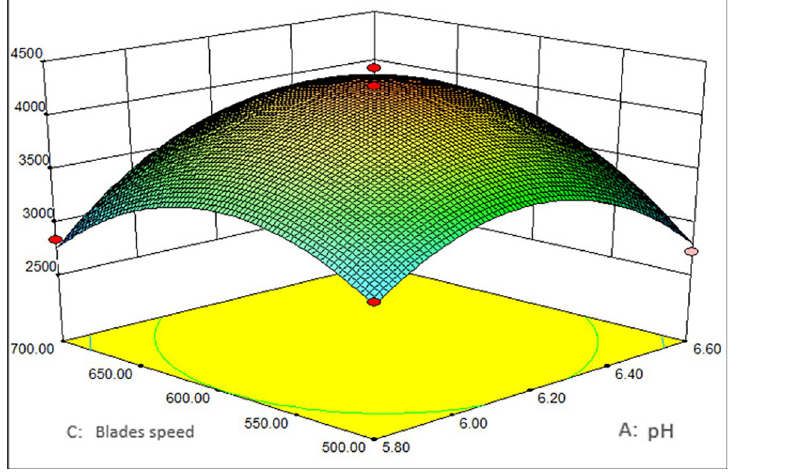
Fig 2. Interaction of blades speed and pH vs. the yield of